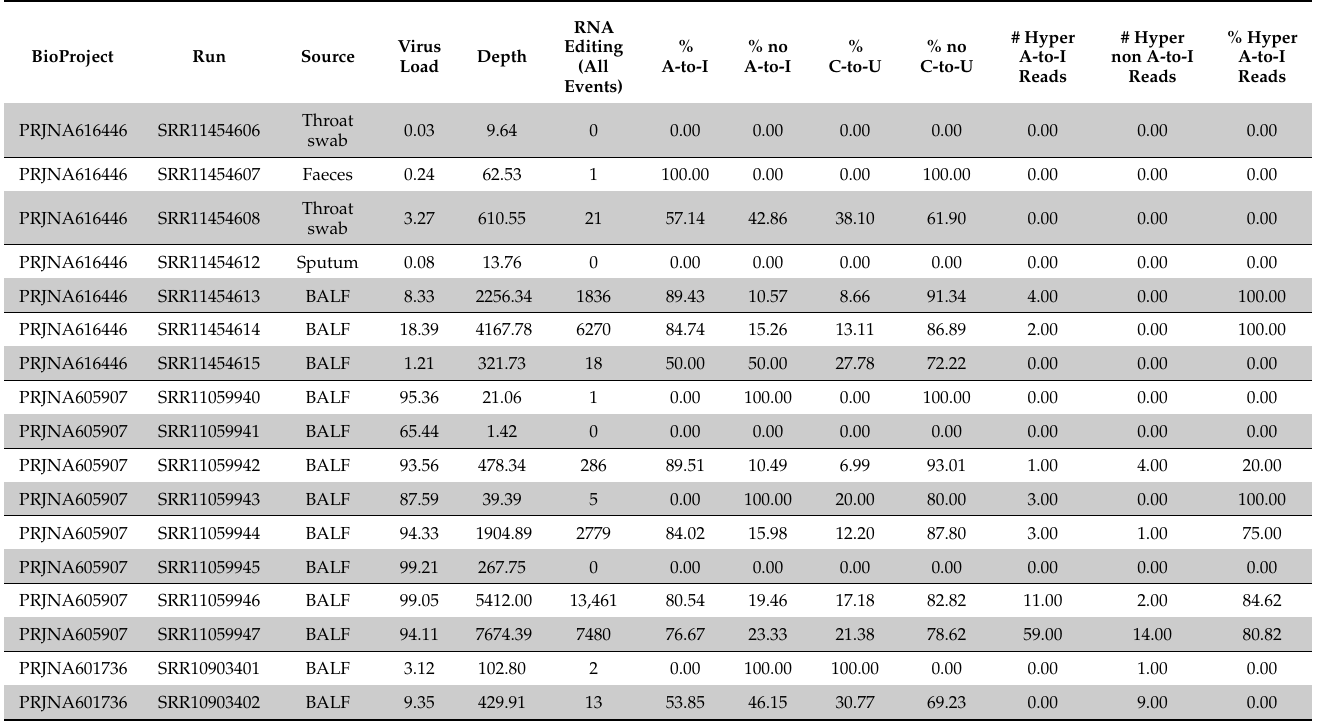
Table 1. RNA editing in clinical samples. Here, we report the total number of RNA editing events found at single-nucleotide levels as well as the number and fraction of hyper-edited reads. For each sample, we include the BioProject and run accession, the sampling source, the virus load and genomic depth, the fraction of A-to-I and C-to-U RNA editing events, and the number of hyper-edited reads. Further statistics are in Supplementary Table S1. # This character means percentage of hyper not A-to-I